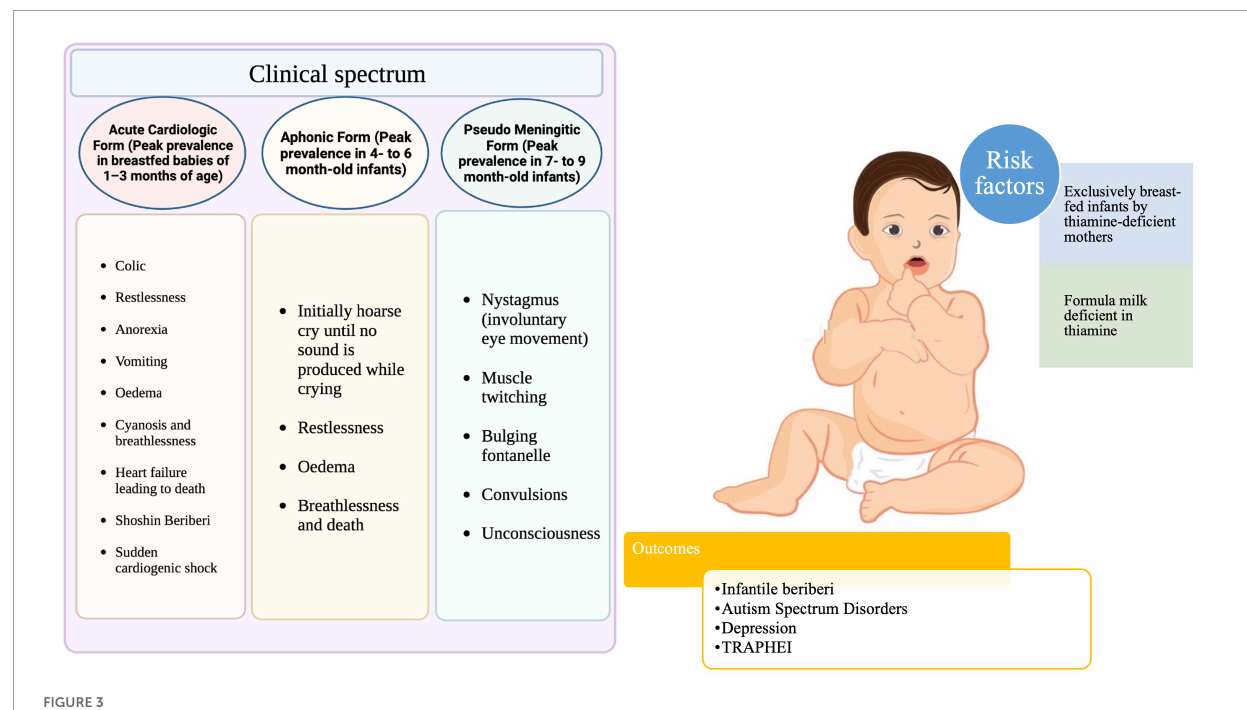
FIGURE3 Clinical consequences of thiamine deficiency in